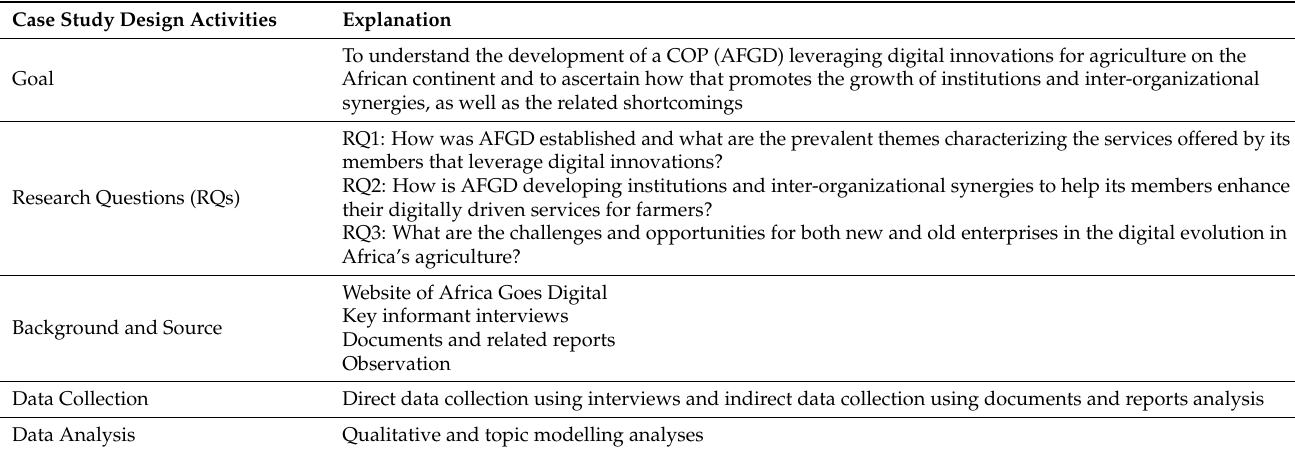
Table 1. Case study